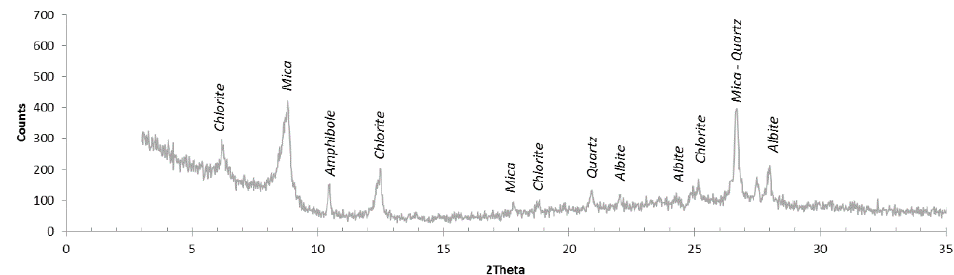
Figure 1. X-Ray Di ff raction pattern of the clay fraction of soil. Figure 1. X-Ray Diffraction pattern of the clay fraction of soil. Table 2. Soil chemical Table 2. Soil chemical composition.